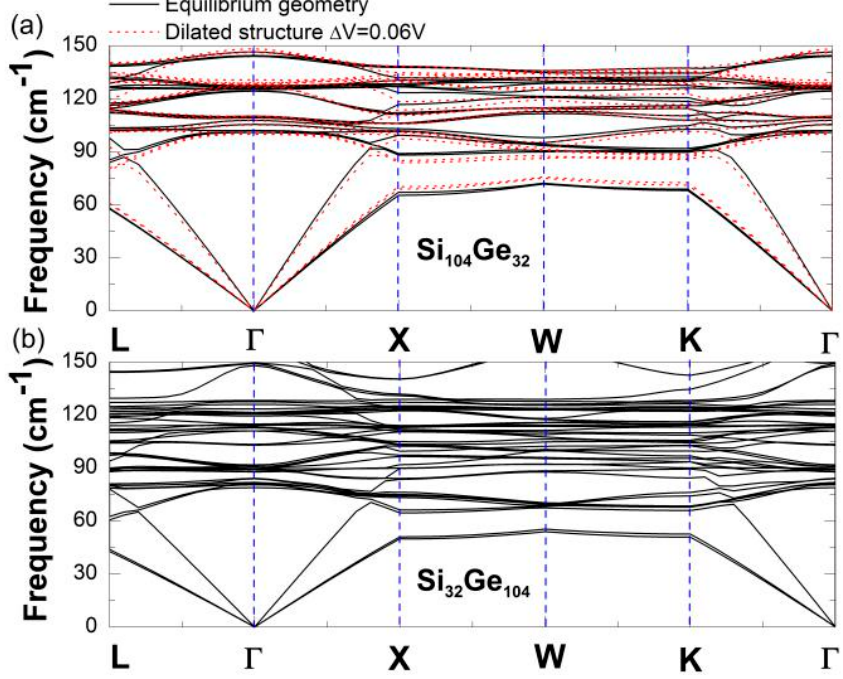
Figure 5. Low-frequency dispersion relationship curves of ( a ) Si 104 Ge 32 and ( b ) Si 32 Ge 104 in the Brillouin zone, for the optimized geometry (black solid line) and dilated configuration (red dotted line).